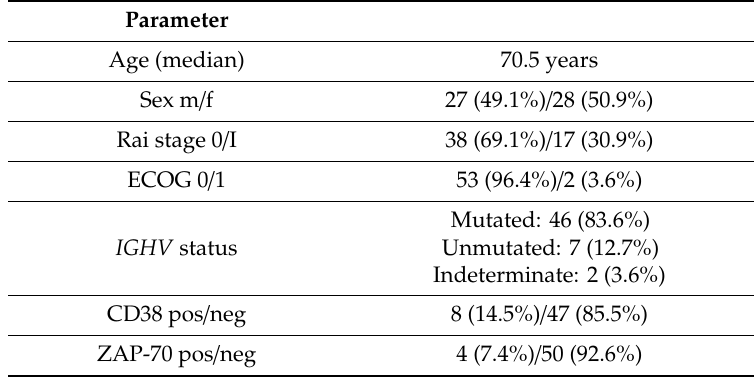
Table 1. Clinical and biological characteristics of patients with chronic lymphocytic leukemia